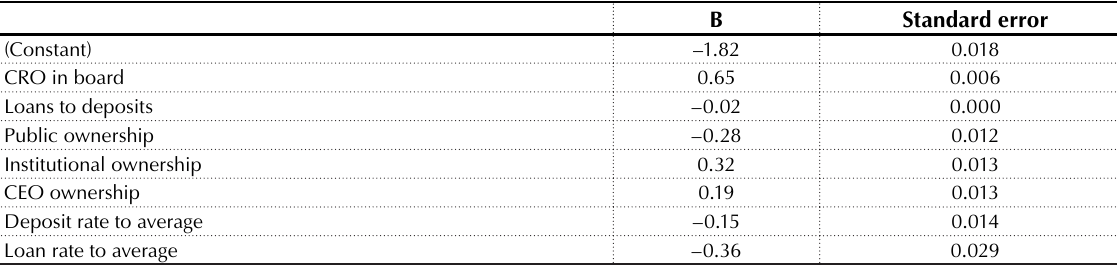
Table 2. Linear regression model for the prediction of the final state of the